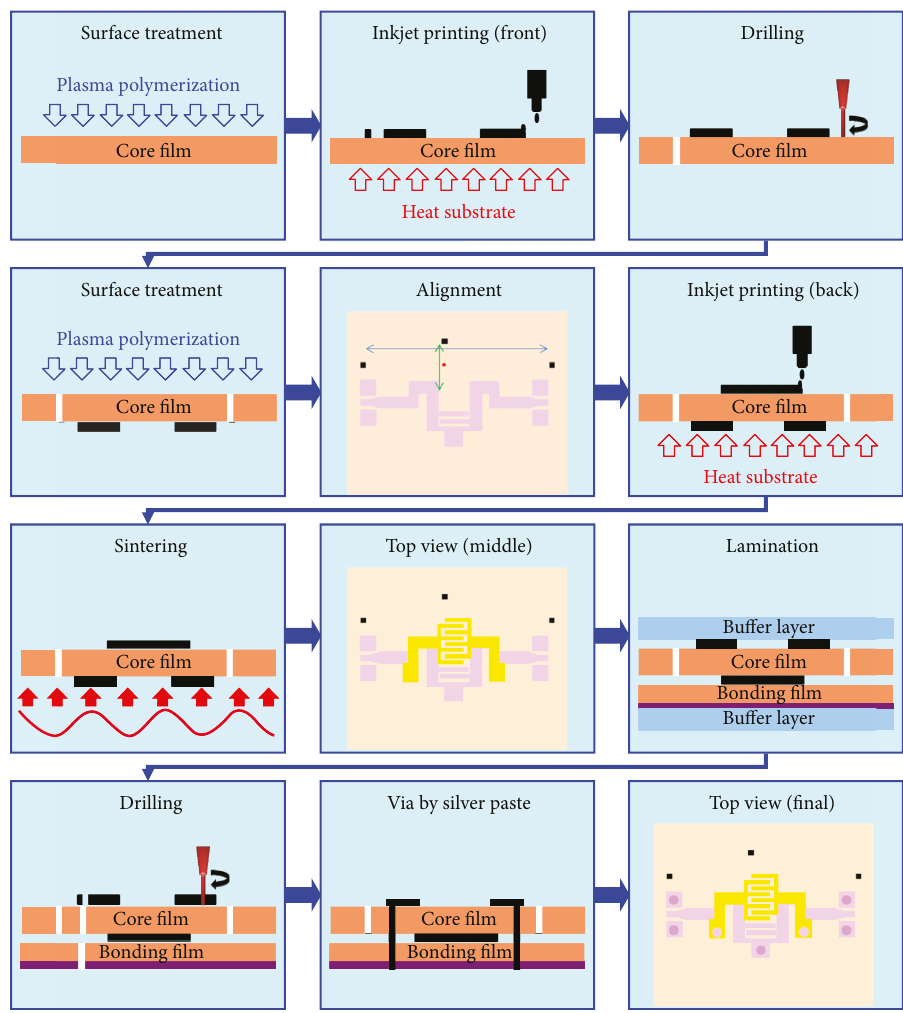
Figure 1: Inkjet printing and lamination bonding process fl